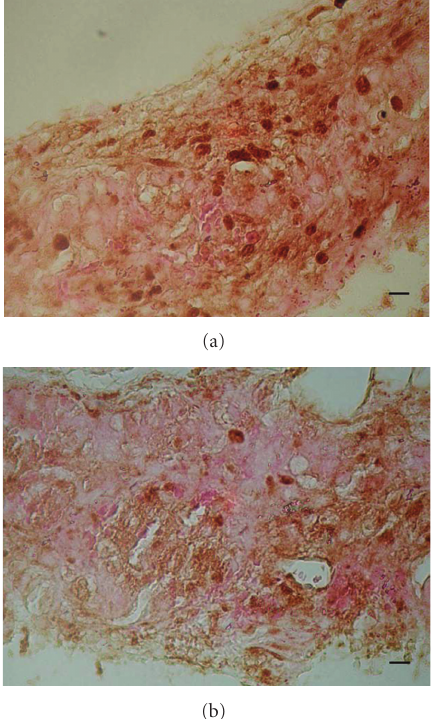
Figure 2: Short-term ex vivo e ff ect of p27 Kip1 silencing on islet cell proliferation in diabetic syngeneic recipients. Batches of 50 of targeting (a) or non-targeting (b) transduced islets were implanted in the subcapsular space of the left kidney of B6 mice with streptozotocin-induced diabetes, and grafts were removed 6 days later for immunohistochemistry by using the anti-Ki67 antibody. The deep-colored oval structures represent positively stained nuclei. The black scale bar indicates a length of 10